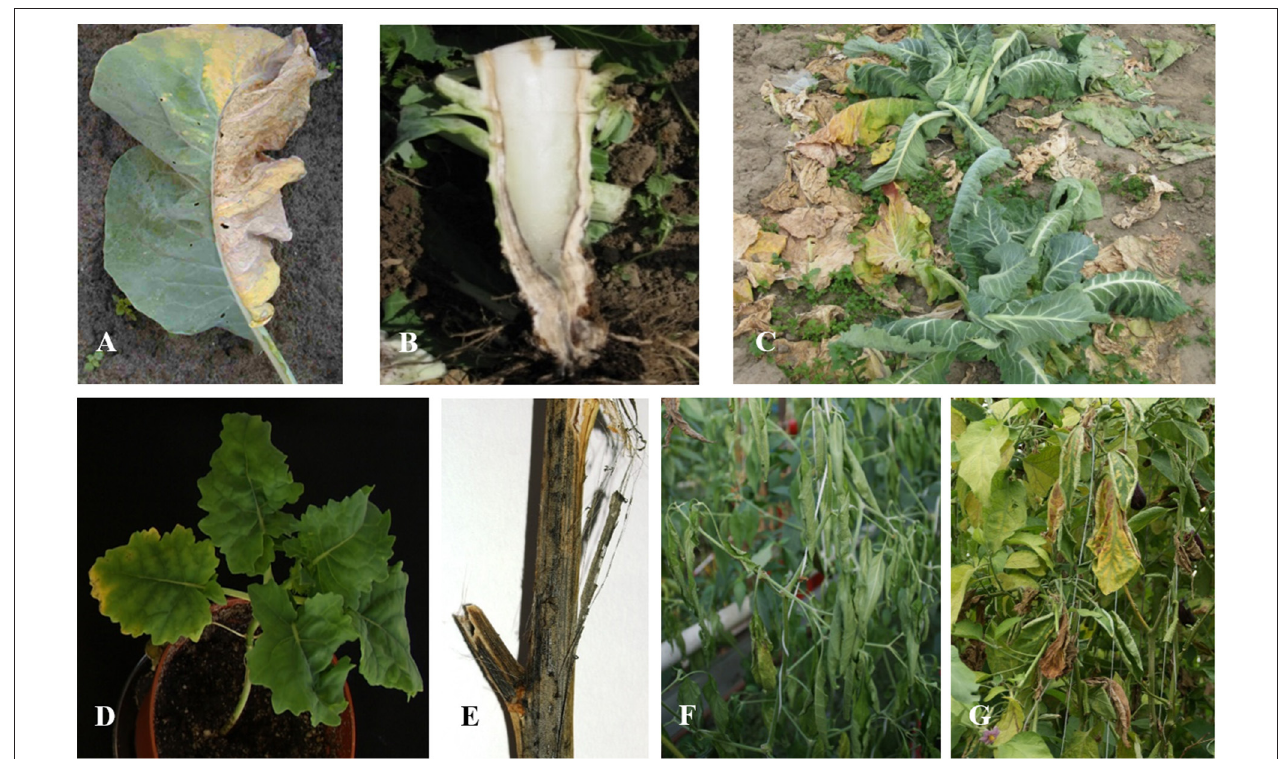
FIGURE 1 | Symptoms caused by Verticillium spp. Verticillium wilt of cauliflower (A–C): Asymmetric chlorosis of the leaves (A) ; Vascular discoloration of the stem (B) ; Wilting of cauliflower plants in the field (C) . Verticillium symptoms on oilseed rape (D,E) : Stunted growth and vein clearing in oilseed rape caused by artificial infection of V. longisporum (D) ; Verticillium stem striping in oilseed rape caused by V. longisporwn , formation of microsclerotia in the stem cortex beneath the epidermis (E) . Pepper plants infected by V. dahliae showing wilted leaves (F) . Eggplant infected by V. dahliae showing chlorosis and necrosis of leaves (G)